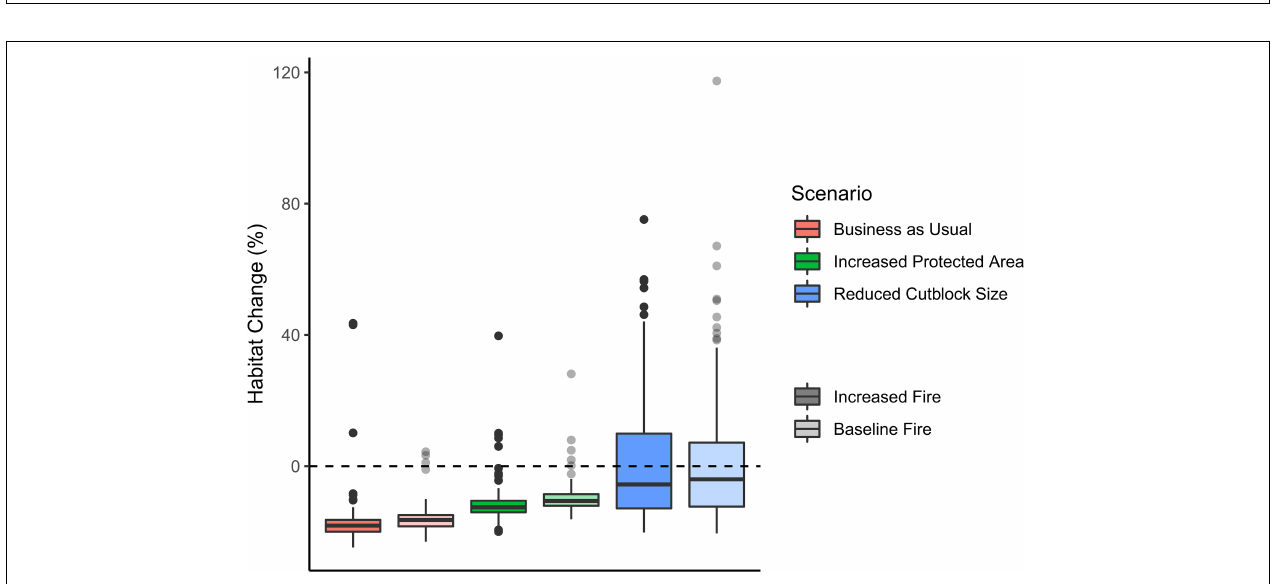
FIGURE 4 | Percent change in habitat suitability for olive-sided flycatchers from 2020 to 2050 across the southern Peace River region of British Columbia under six scenarios of landscape change. Habitat suitability was calculated for 2020 and 2050 by multiplying the projected probability of olive-sided flycatcher occurrence (per ha) for each simulation cell by the area of the cell (0.81 ha) then summing over all cells. Percent change in habitat suitability was the difference between suitable habitat in 2020 vs. 2050, divided by suitable habitat in 2020 and multiplied by 100. Thick black bars indicate the median % habitat change from 100 Monte Carlo realizations, boxes indicate the 1st and 3rd quartiles, whiskers extend to the maximum and minimum values within 1.5 × the interquartile range, and points indicate the results of simulations that fell outside of this range. Variation in the projected change in habitat suitability within each scenario reflects both uncertainty in the simulations of land cover, and uncertainty in the parameters of habitat suitability models for olive-sided flycatcher. Darker shades of color indicate Increased Fire scenarios (50% increase in fire frequency), and lighter shades indicate Baseline Fire scenarios (fire frequency remained at the historic average).